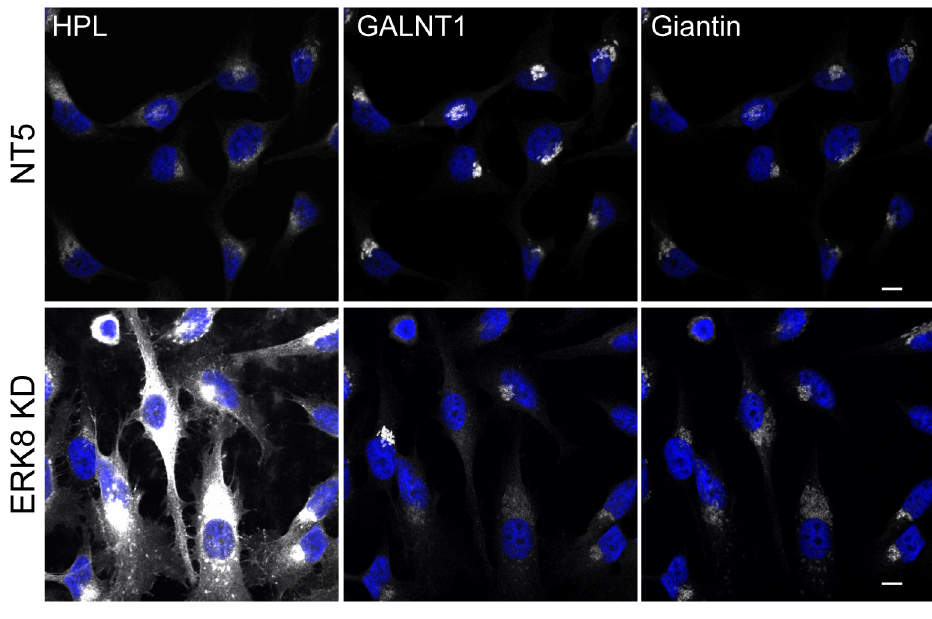
Fig 1. GALNT1 signal in the